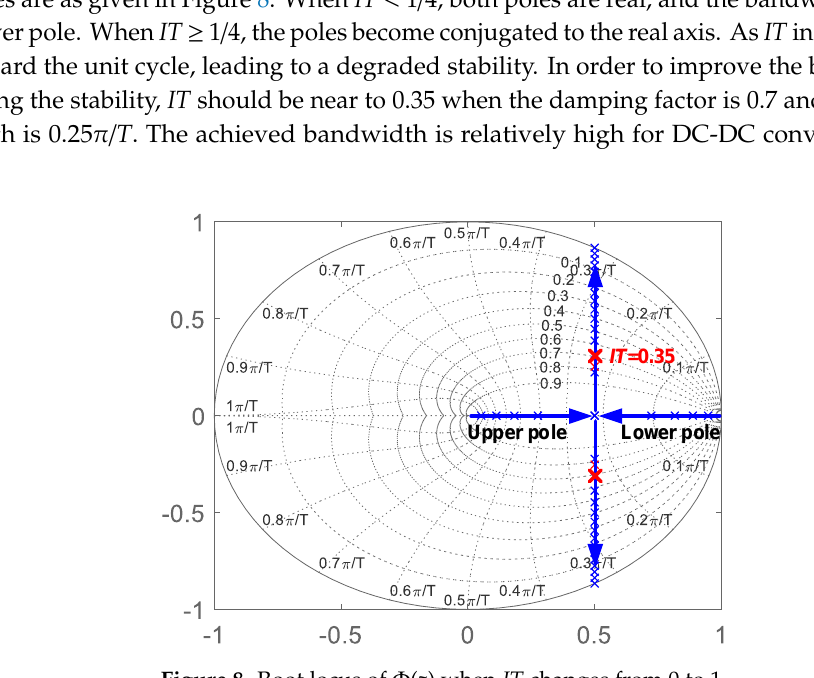
Figure 7. DPVP control with integral compensation: ( a ) Control scheme and ( b ) closed-loop equivalent model.